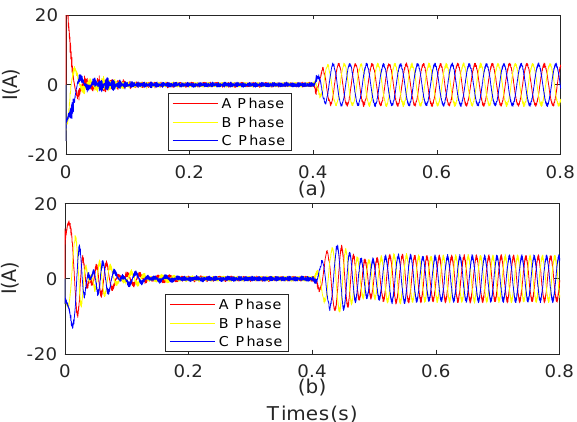
Figure 16. Three phase current response process under two control methods. ( a ) Current response under the proposed VPDPI control. ( b ) Current response under the PI control method